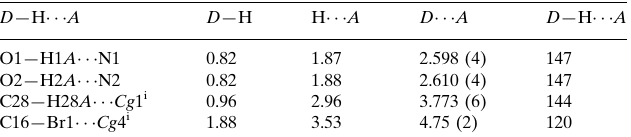
Hydrogen-bond geometry (A˚ , (cid:1)